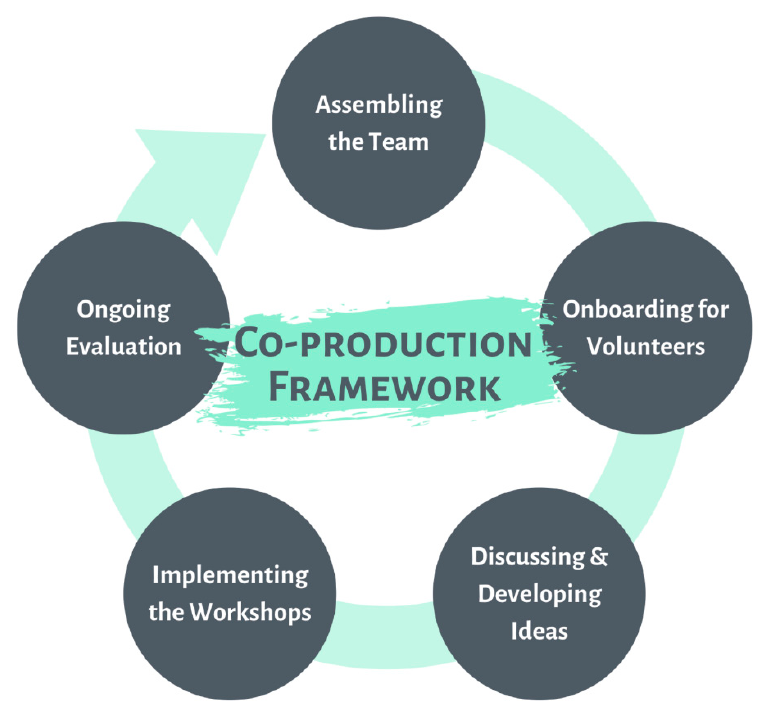
Figure 2. A framework for co-production to co-create and co-develop psychoeducation workshops for people with an interest in psychotic disorders. Five steps are identified in this framework (1) Assembling the Team, (2) On-boarding of Volunteers, (3) Discussing and Developing Concepts, (4) Implementation of the Workshops, and (5) Ongoing Evaluation.